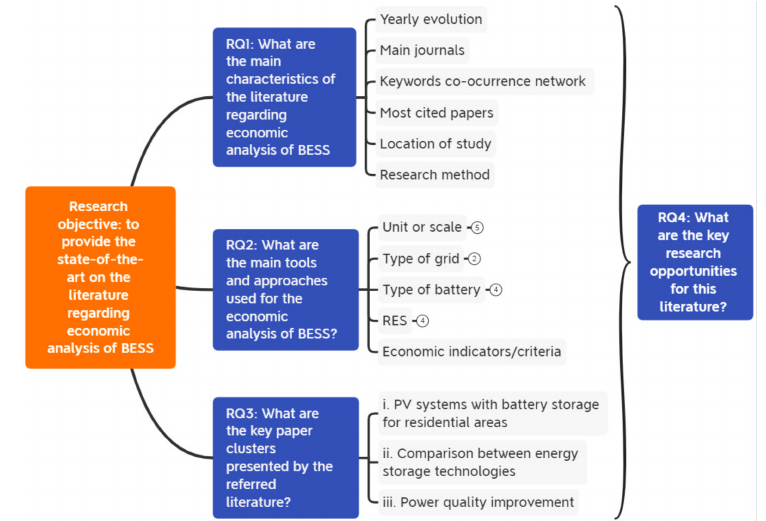
Figure 2. General overview of the research